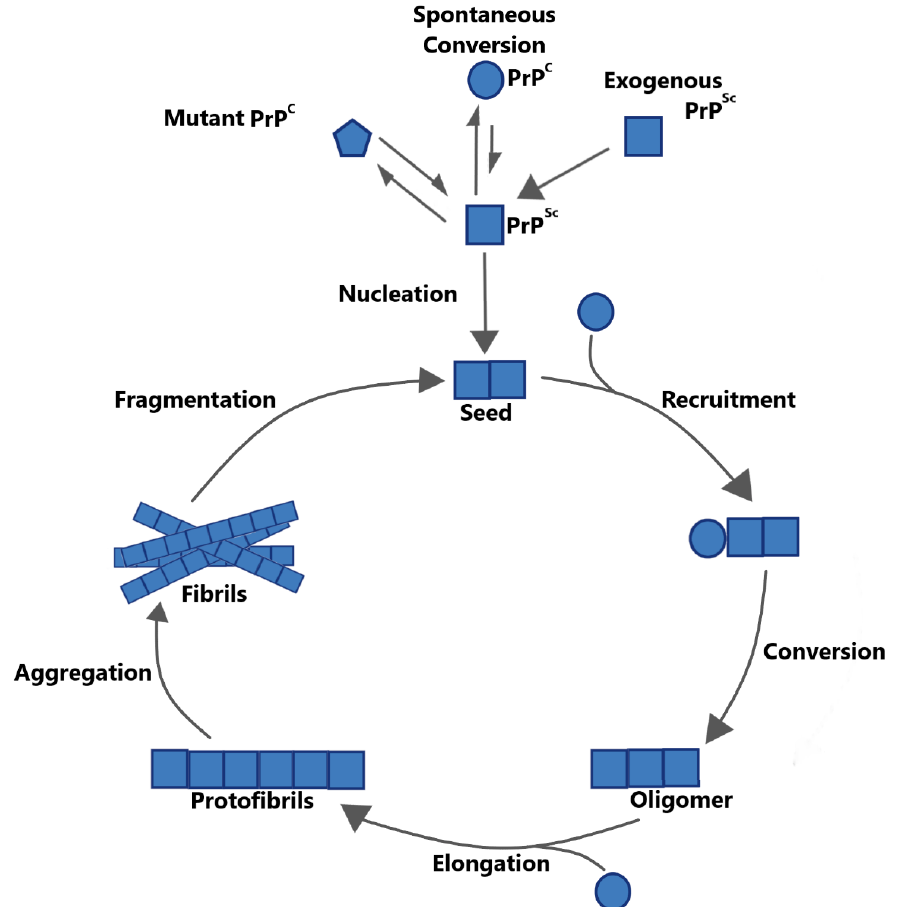
Figure 1. Seeded nucleation model exemplified by the cellular prion protein and its misfolded isoform (PrP C / PrP Sc ). The formation of PrP Sc , and thus prion disease, can be initiated by the spontaneous conversion of wild-type PrP C (circles) by inherited mutations in the PRNP gene (pentagon) or by infection with exogenous PrP Sc (squares). Initial PrP Sc undergoes nucleation forming a seed, which then recruits and converts further PrP C . This leads to the formation of oligomers, protofibrils, and ultimately, fibrillar aggregates. Due to the low ratio of exposed ends to their mass, fibrils are not e ffi cient at converting further PrP C . Thus, fragmentation is required to generate new seeds, allowing the cycle to